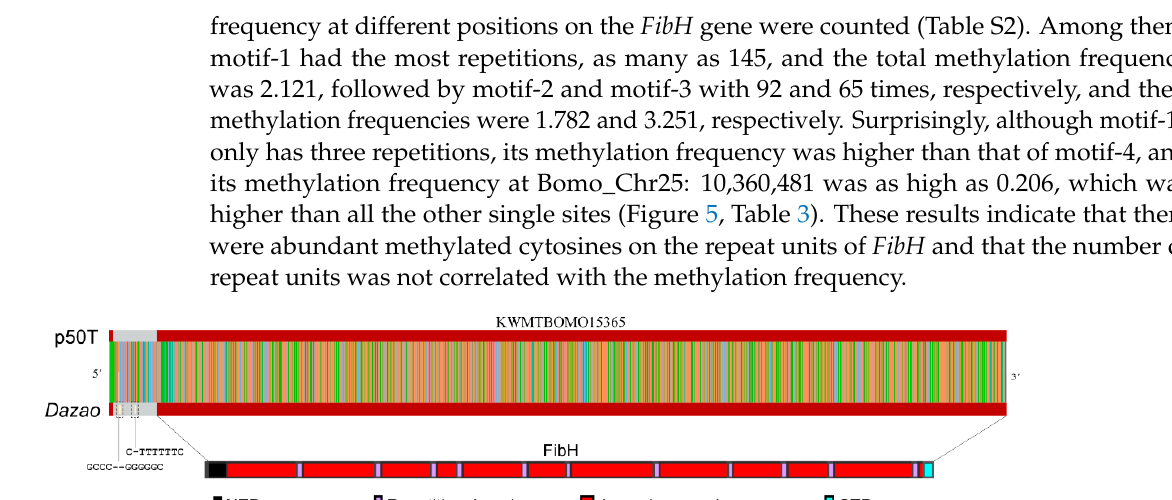
Figure 4. The precise characterization of FibH by Cpf1-based enrichment and ONT sequencing (CEO). The upper half of the figure is a comparison between the FibH (KWMTBOMO15365) of the Japanese B. mori p50T strain and the Chinese B. mori Dazao strains using CEO. There were only three base deletions in the intron between the two sequences. The dark red and gray rectangles represent the exon and introns of FibH , respectively. The red, yellow, green, and blue lines represent the guanine, cytosine, adenine, and thymine deoxyribonucleotide residues, respectively. The lower half of the figure shows the amino acid sequence deduced from the nucleotide sequence of the Dazao FibH . FibH is composed of two terminal non-repetitive domains and a central repetitive core, which includes 12 repetitive domains and 11 separated amorphous regions. Black rectangle, N-terminal domain (NTD); blue rectangle, C-terminal domain (CTD); red rectangle, repeat domain (R); and purple rectangle, amorphous region (A).